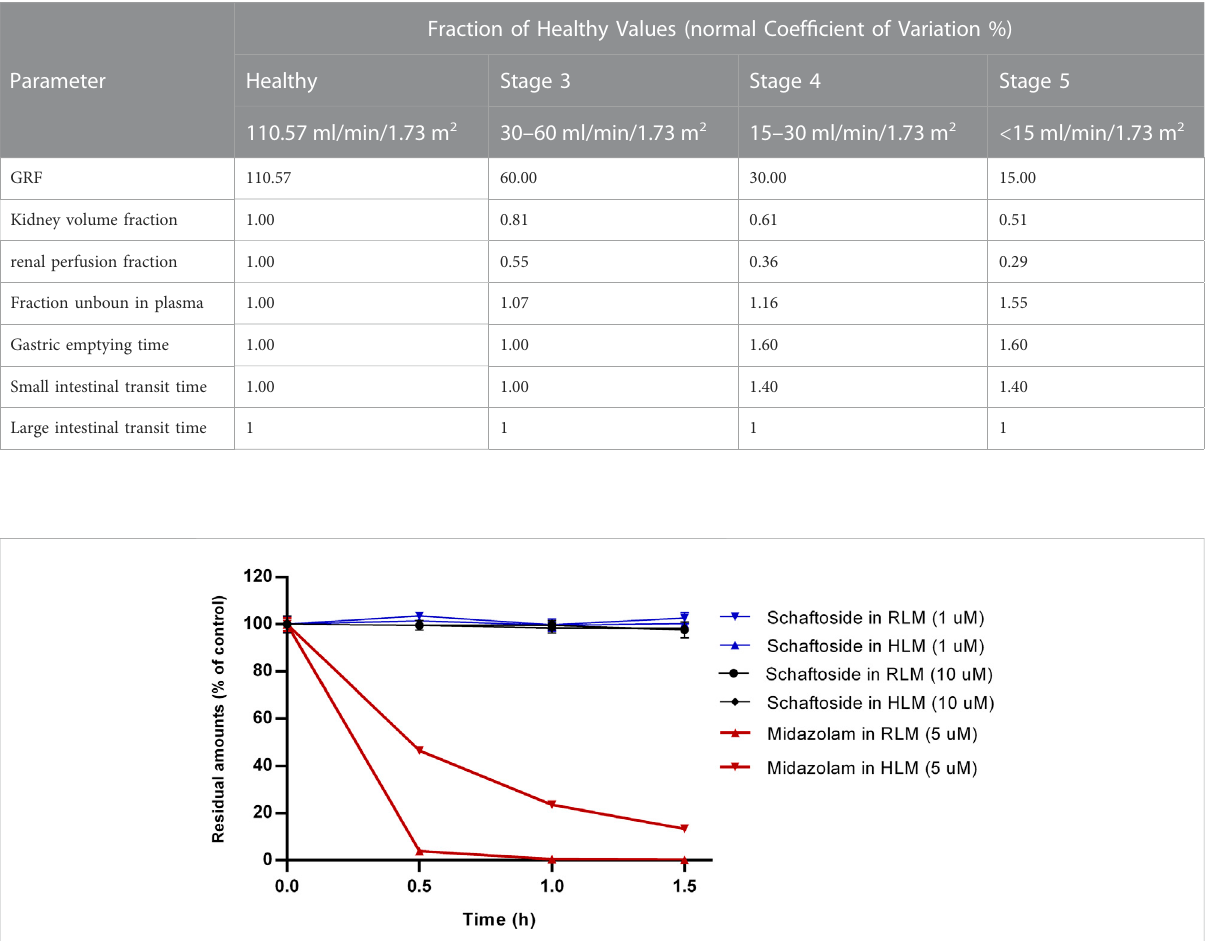
TABLE 2 Categorical parameters in healthy adults and renally impaired patients with different CKD stages (age range: 18 – 40, 50% female).